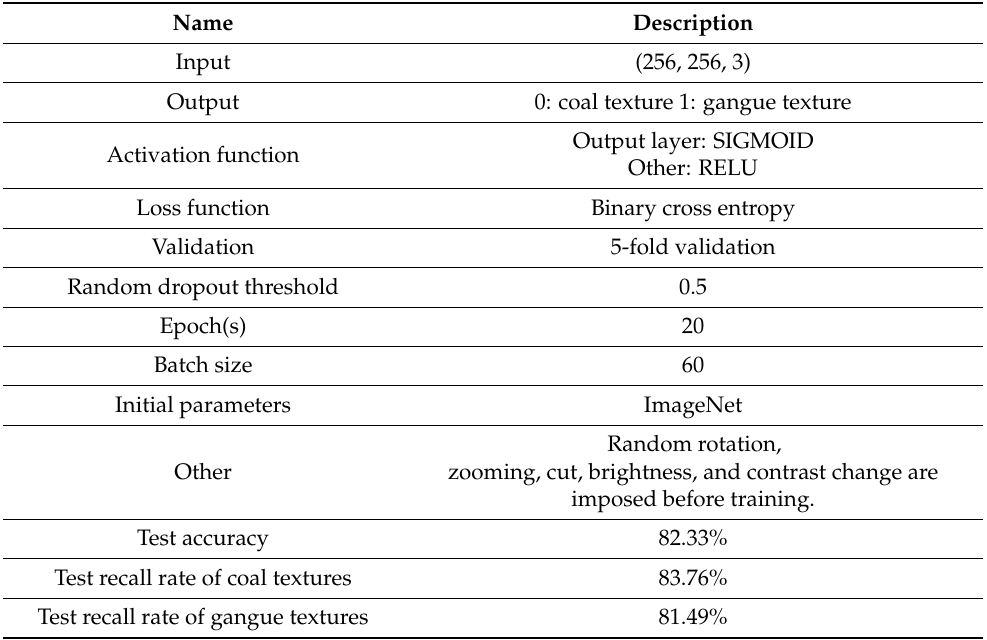
Table 2. Detailed information of CNN